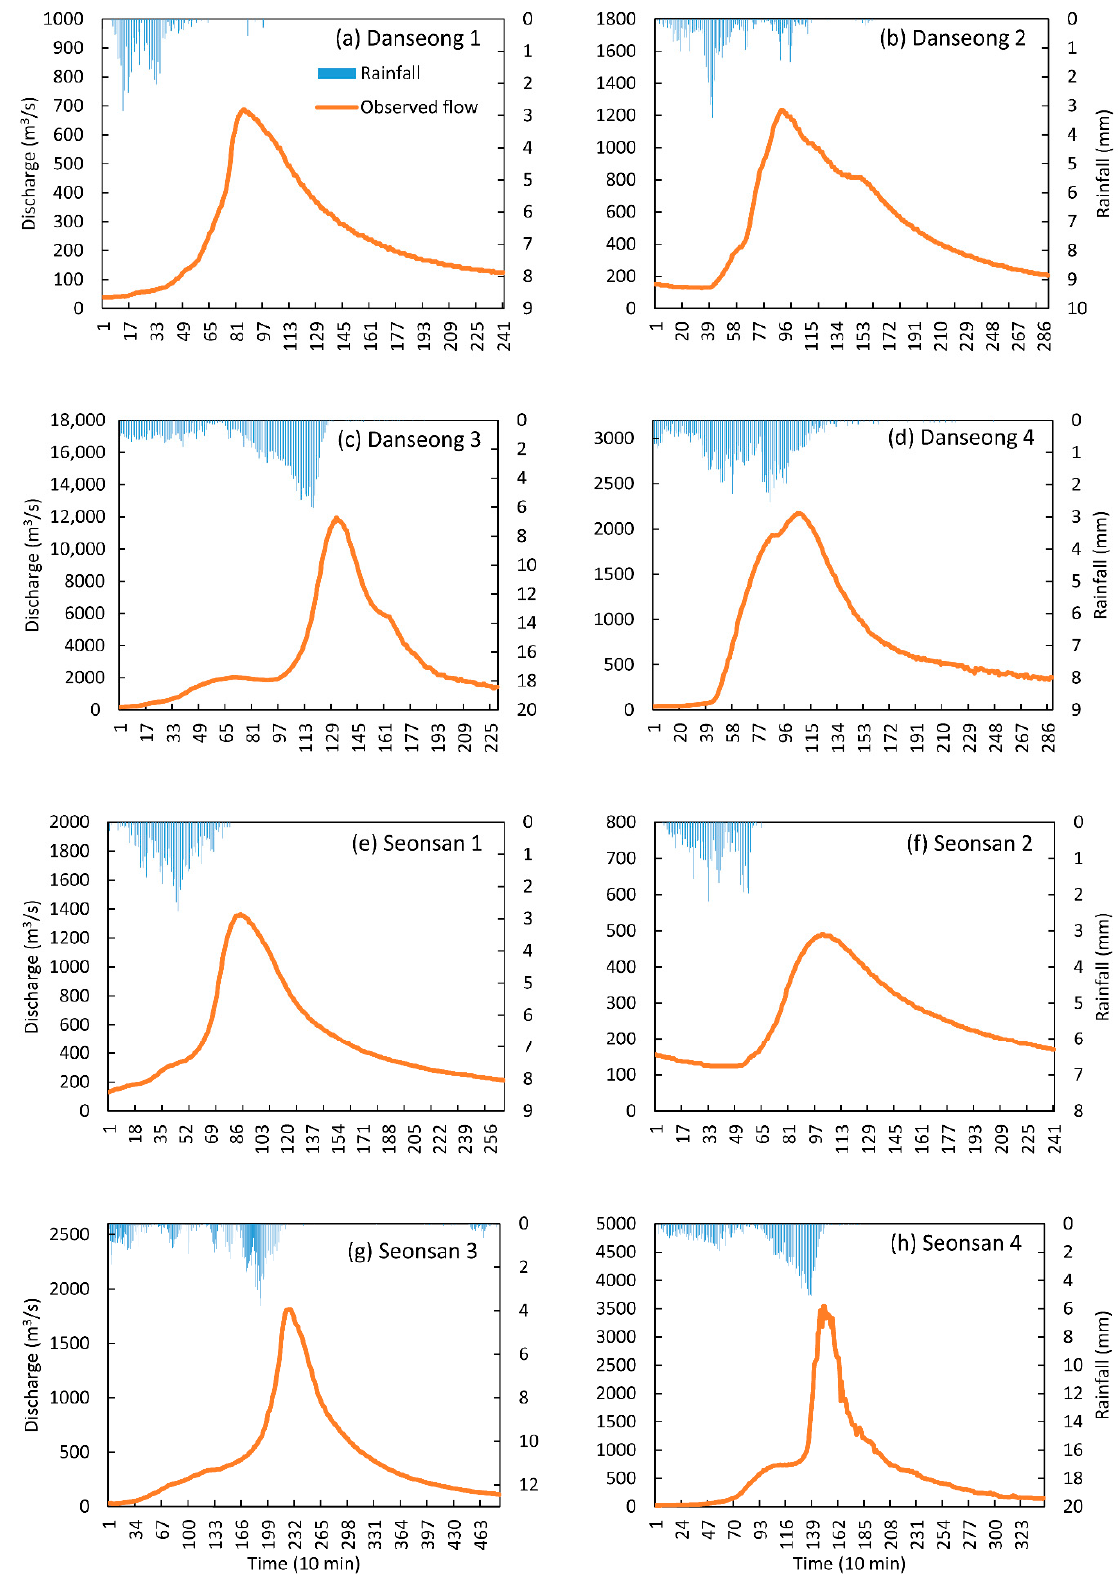
Figure 2. Rainfall time series and observed hydrographs for the eight rainfall events in Danseong and Seonsan catchments. ( a ) Danseong 1; ( b ) Danseong 2; ( c ) Danseong 3; ( d ) Danseong 4; ( e ) Seonsan 1; ( f ) Seonsan 2; ( g ) Seonsan 3; ( h ) Seonsan 4.